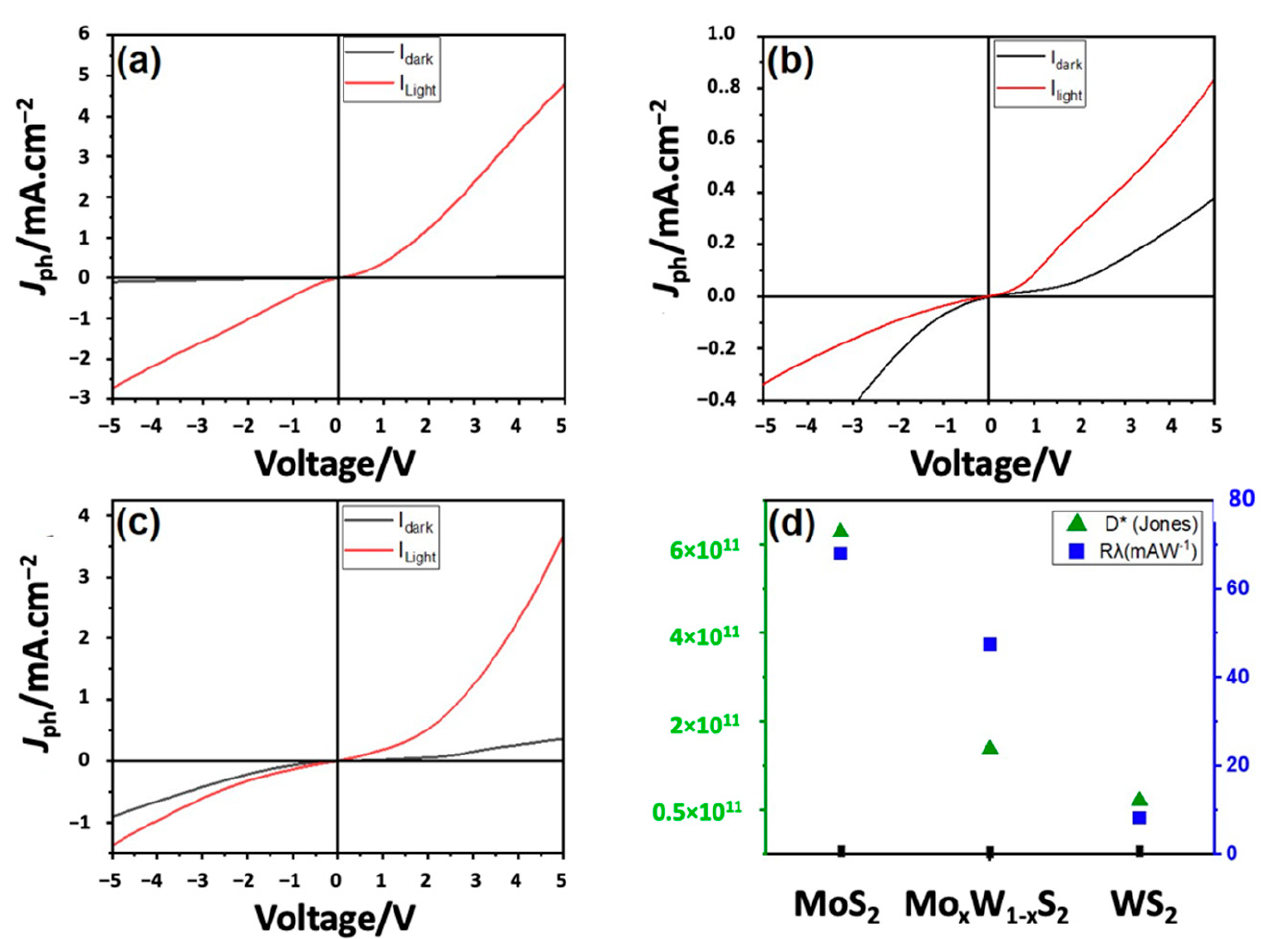
Figure 10. ( a ) Photocurrent density measurements for ( a ) MoS 2 , ( b ) WS 2 , ( c ) Mo x W 1-x S 2 , and their respective ( d ) responsivity and relative detectivity obtained under halogen lamp illumination (70 mW/cm 2 ).